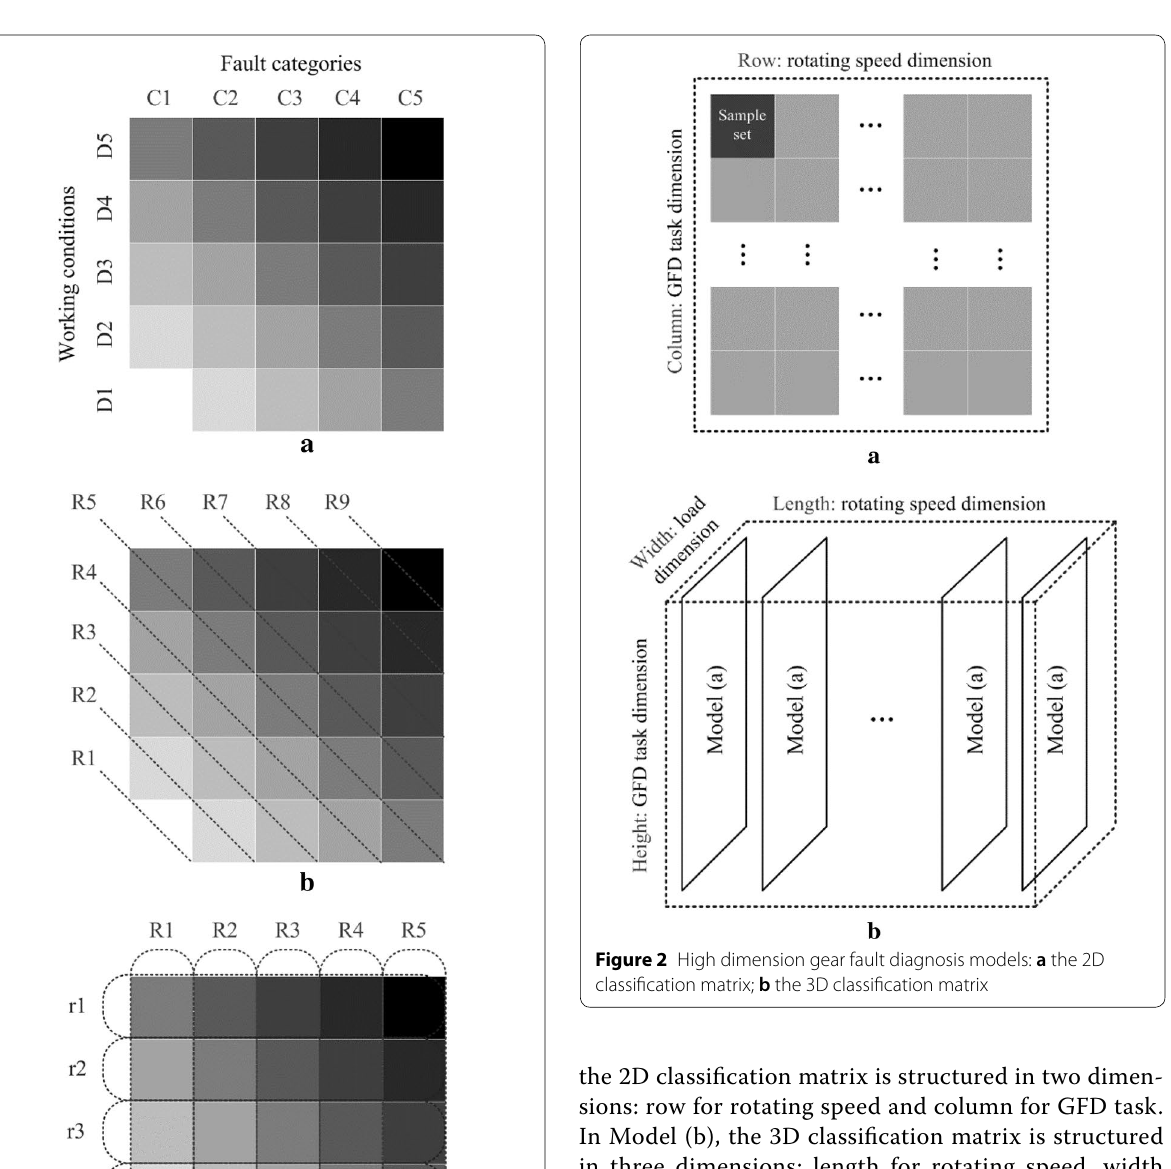
the more complex problem such as the gear fault diag- nosis problem under multiple working conditions. Fig- ure 2 explains the mechanism of co-clustering GFD models under two working condition factors, such as varying rotating speed and varying load. In Model (a),